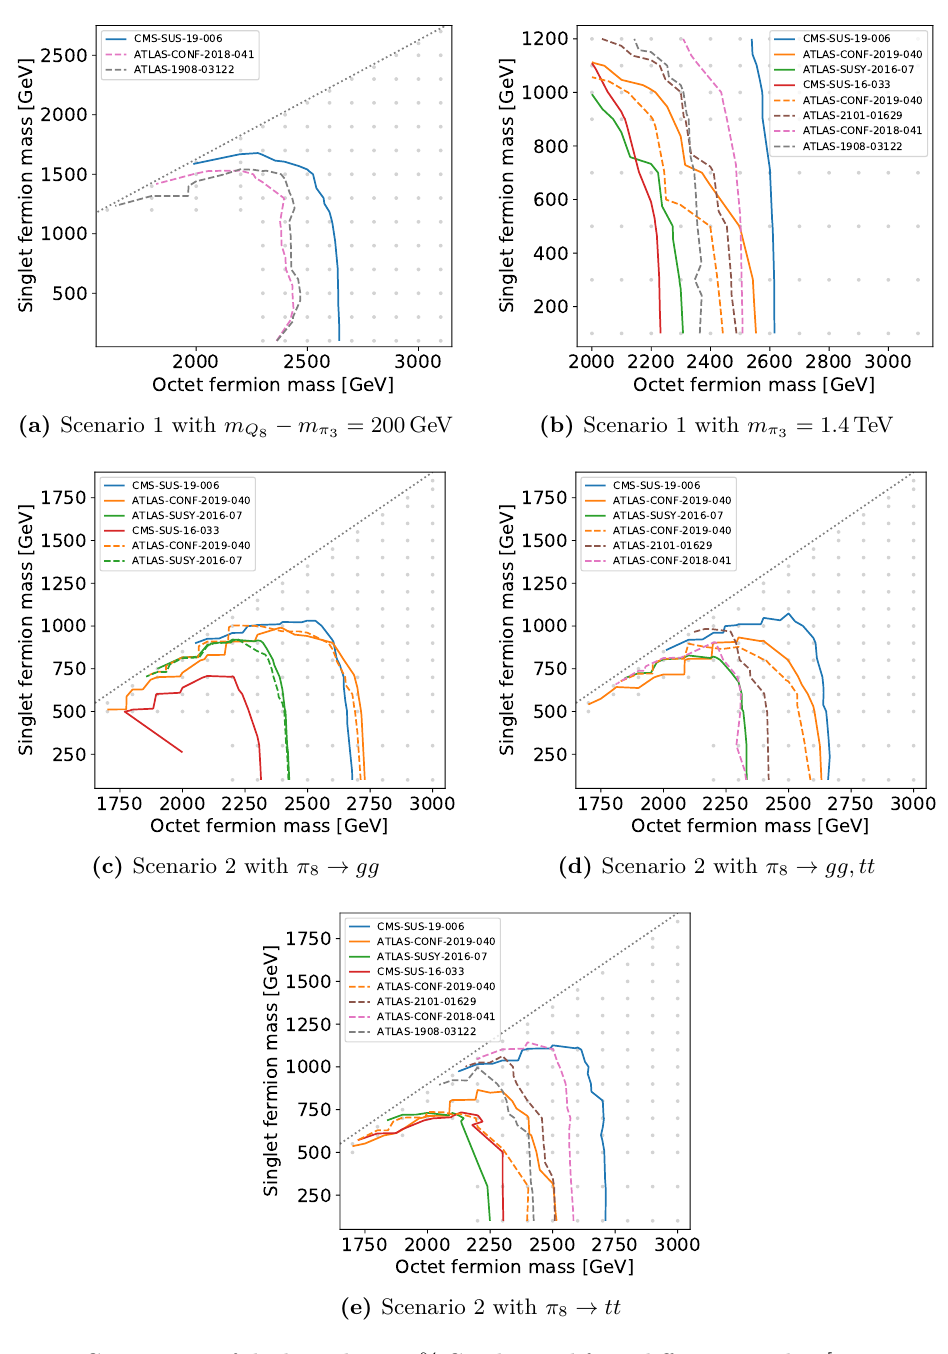
Figure 10. Comparison of the bounds at 95% CL obtained from different searches [59, 108, 109, 114– 117] implemented in MA (solid lines) and CM (dashed lines) for scenario (S1c) in (a)-(b) and scenario (S2b) with m = 1 . 1 TeV in π 8